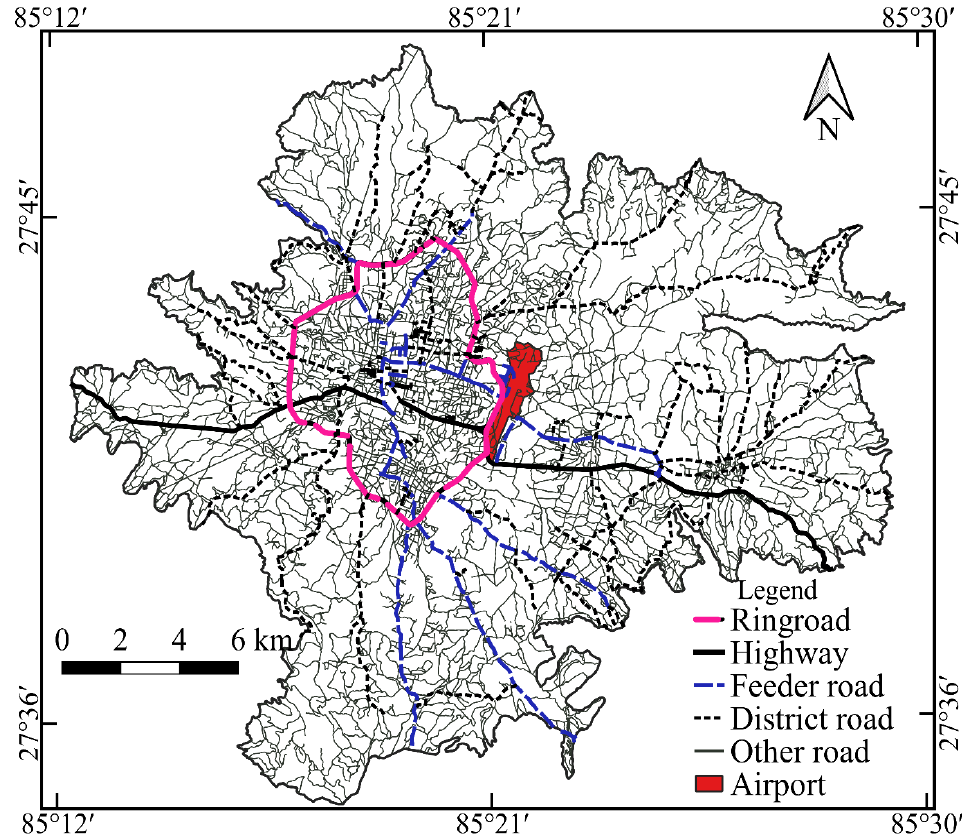
Figure 5. Road network and airport in Kathmandu Valley.